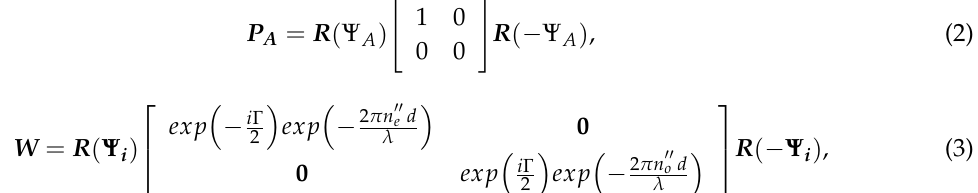
Figure 3. Experiment setup for terahertz measurements.